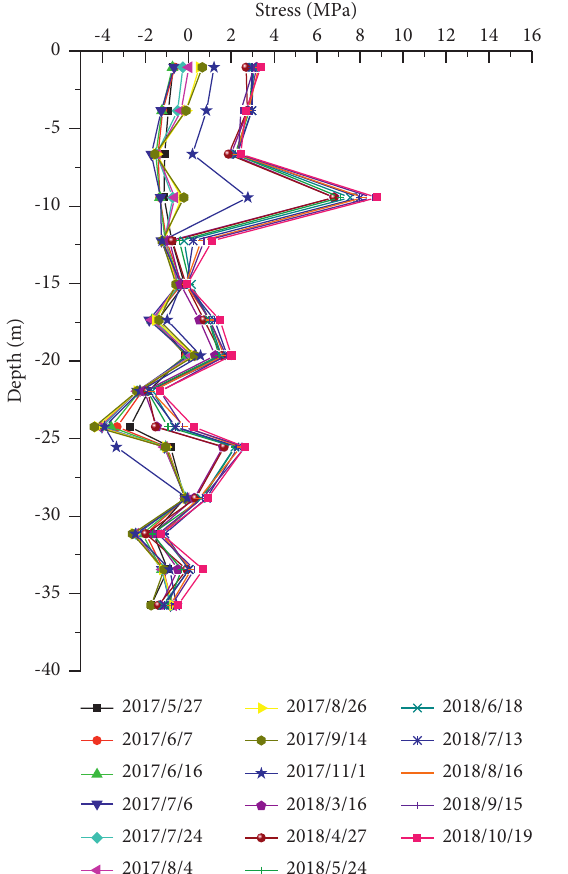
Figure 7: 4# stress curve of bridge pier pile foundation at different depths.